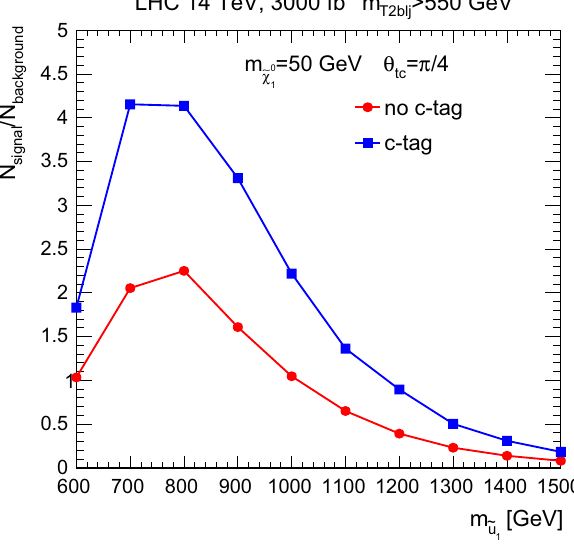
for the Case-A (red, rounds) 1